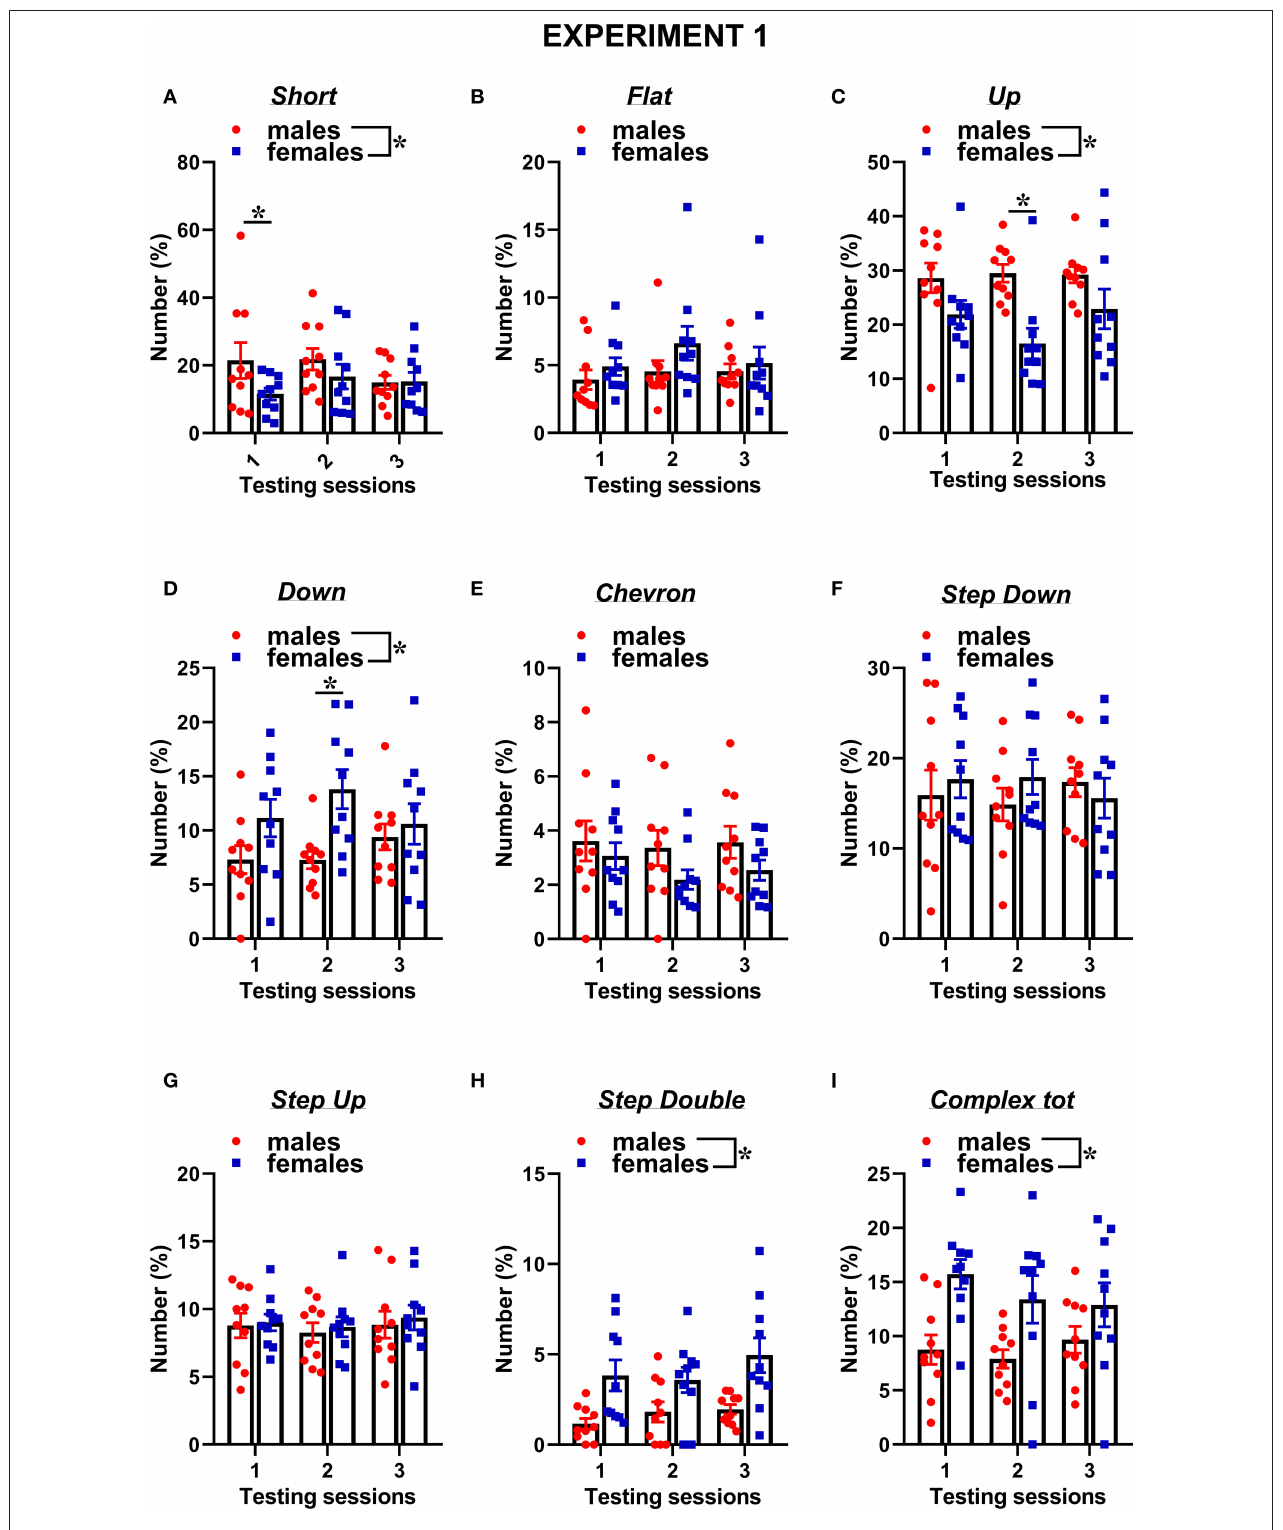
FIGURE 3 | Sex differences in ultrasonic call types in experiment 1 (same pre-testing isolation). (A–I) The different call types were automatically classified as detailed in Figure 1 . Complex tot = complex 3 + complex 4 + complex 5. Data are expressed as percentages over the total number of USVs for each sex and session. Data are mean ± SEM. N = 10 for each sex. * p < 0.05. * Refers to a nonsignificant tendency (0.05 < p ≤ 0.09). Sex differences are reported as * in each graph legend when a significant main effect of sex was detected in the absence of any interaction with testing session.